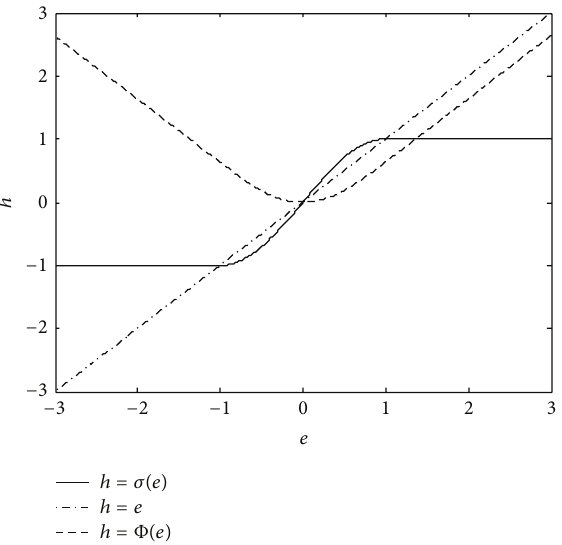
Figure 1: The curves of Φ(𝑒) , 𝜎(𝑒) , and 𝑒 (𝛽 = 1)